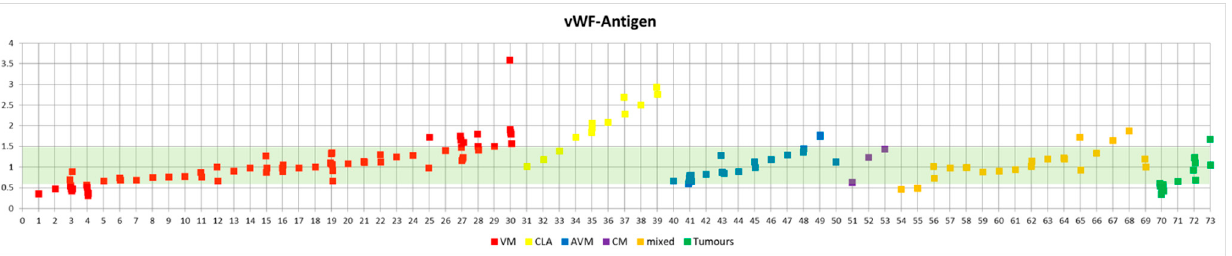
Figure 1. Graphical representation of the vWF:Ag in patients with different entities of vascular anomalies. The reference range of vWF:Ag is highlighted in green.